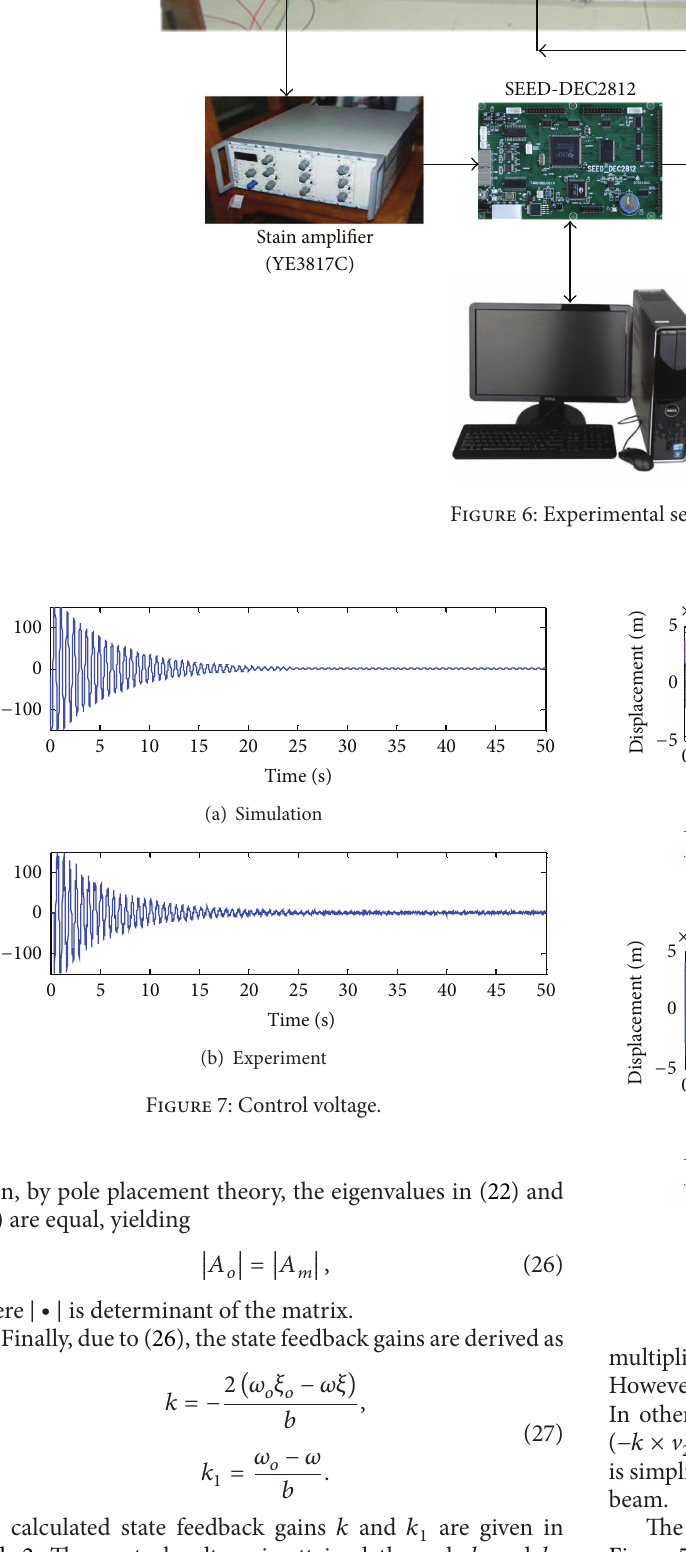
Figure 5. The actual damping ratio 𝜉 of the close loop